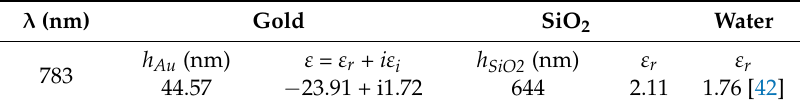
Table 1. The thickness and dielectric constants of the gold thin film and SiO 2 obtained from the SPR curves fitting.